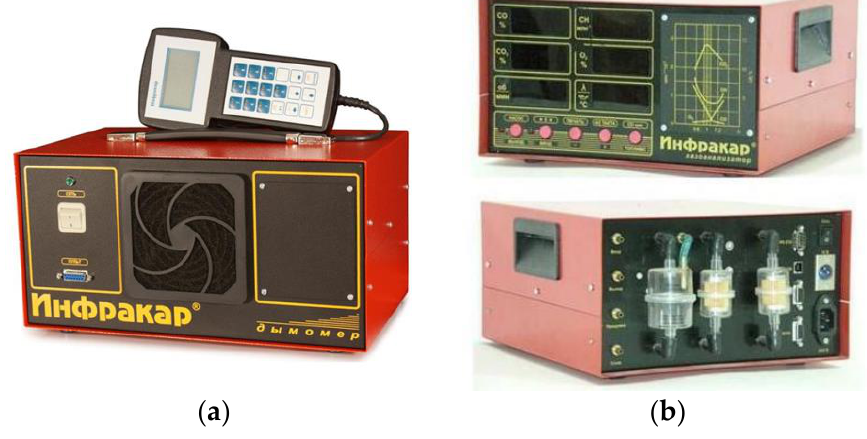
Figure 3. Smoke meter ( a ) and exhaust gas analyzer ( b ). Table 2. Main measurement parameters.